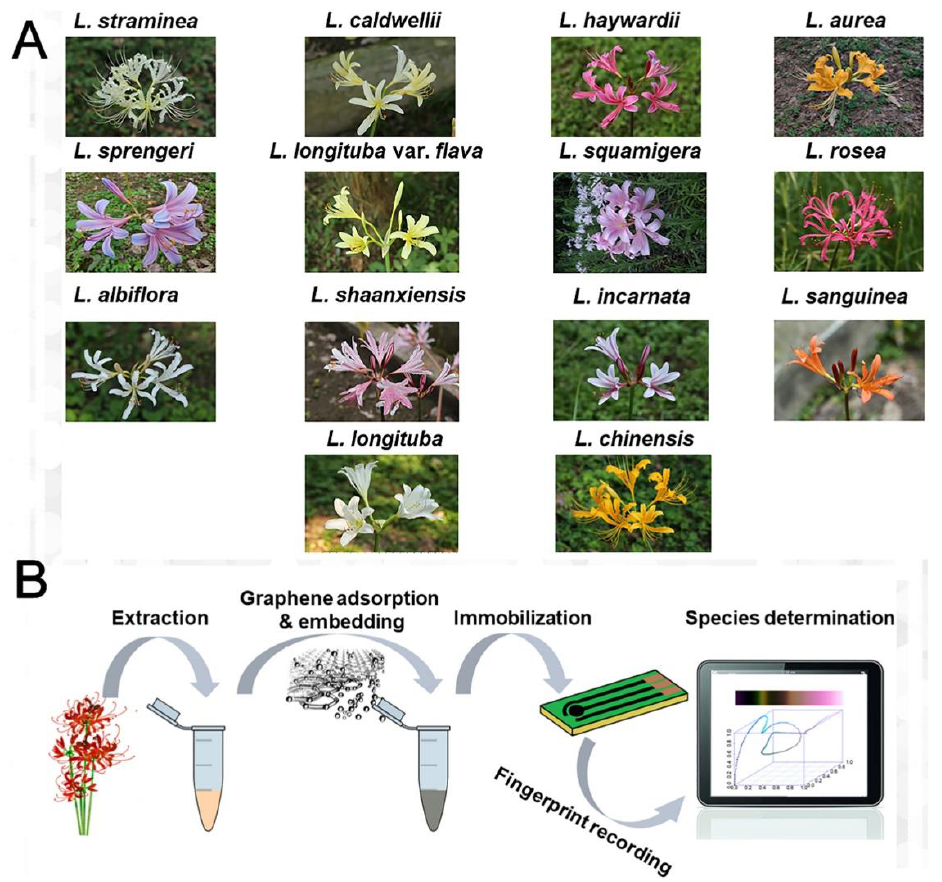
Figure 3. ( A ) Digital photographs of 14 flowers species of Lycoris and ( B ) its schematic diagram for fingerprinting recording using its petals for species determination. Reprinted with permission from reference [57], Elsevier, 2019.